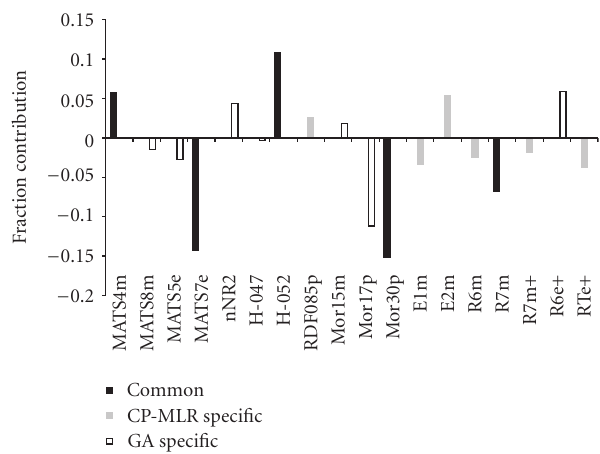
F2:PlotoffractioncontributionsofMLR-likePLScoefficients (normalized)fromthecombineddescriptorsofCP-MLRandGAfor the antimalarial activity of